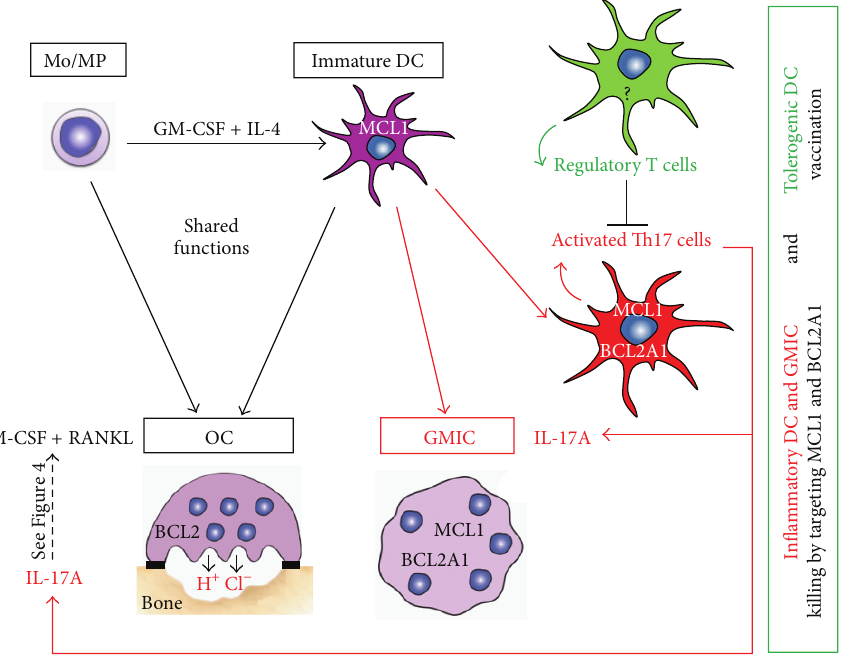
Figure 5: Model for the therapeutical management of diseases associated with IL-17A-dependent chronic inflammation with bone loss. In the context of IL-17A-driven inflammation, IL-17A amplifies OC formation and consequently bone resorption (see details in Figure 4). In addition, IL-17A induces BCL2A1 expression in MCL1 + monocyte-derived DC, DC clustering, and fusion, leading to a mixed culture, containing both mononuclear and multinuclear (GMIC) inflammatory DC. These inflammatory DC and GMIC express MCL1 and BCL2A1 contrarytoOCwhosesurvivalisunderthecontrolofBCL2.TolerogenicDCsactivateregulatoryTcellsabletocontrolactivatedTh17cells.The question mark indicates that the status of BCL2 family in tolerogenic DC is unknown and should be studied to validate this model. In order to cure diseases with IL-17A-dependent chronic inflammation associated with bone loss, we suggest killing inflammatory DC and GMIC by targeting both MCL1 and BCL2A1. In parallel performing therapeutic autologous vaccination with tolerogenic DC may help breaking IL-17A-dependent chronic inflammation to restore normal bone